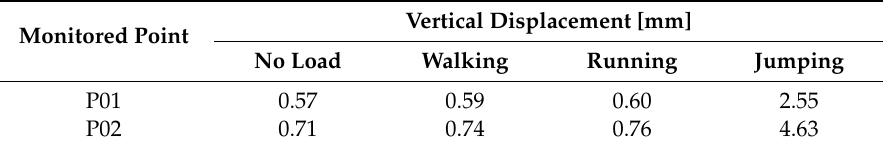
Table 1. Maximum vertical displacements obtained by G-B